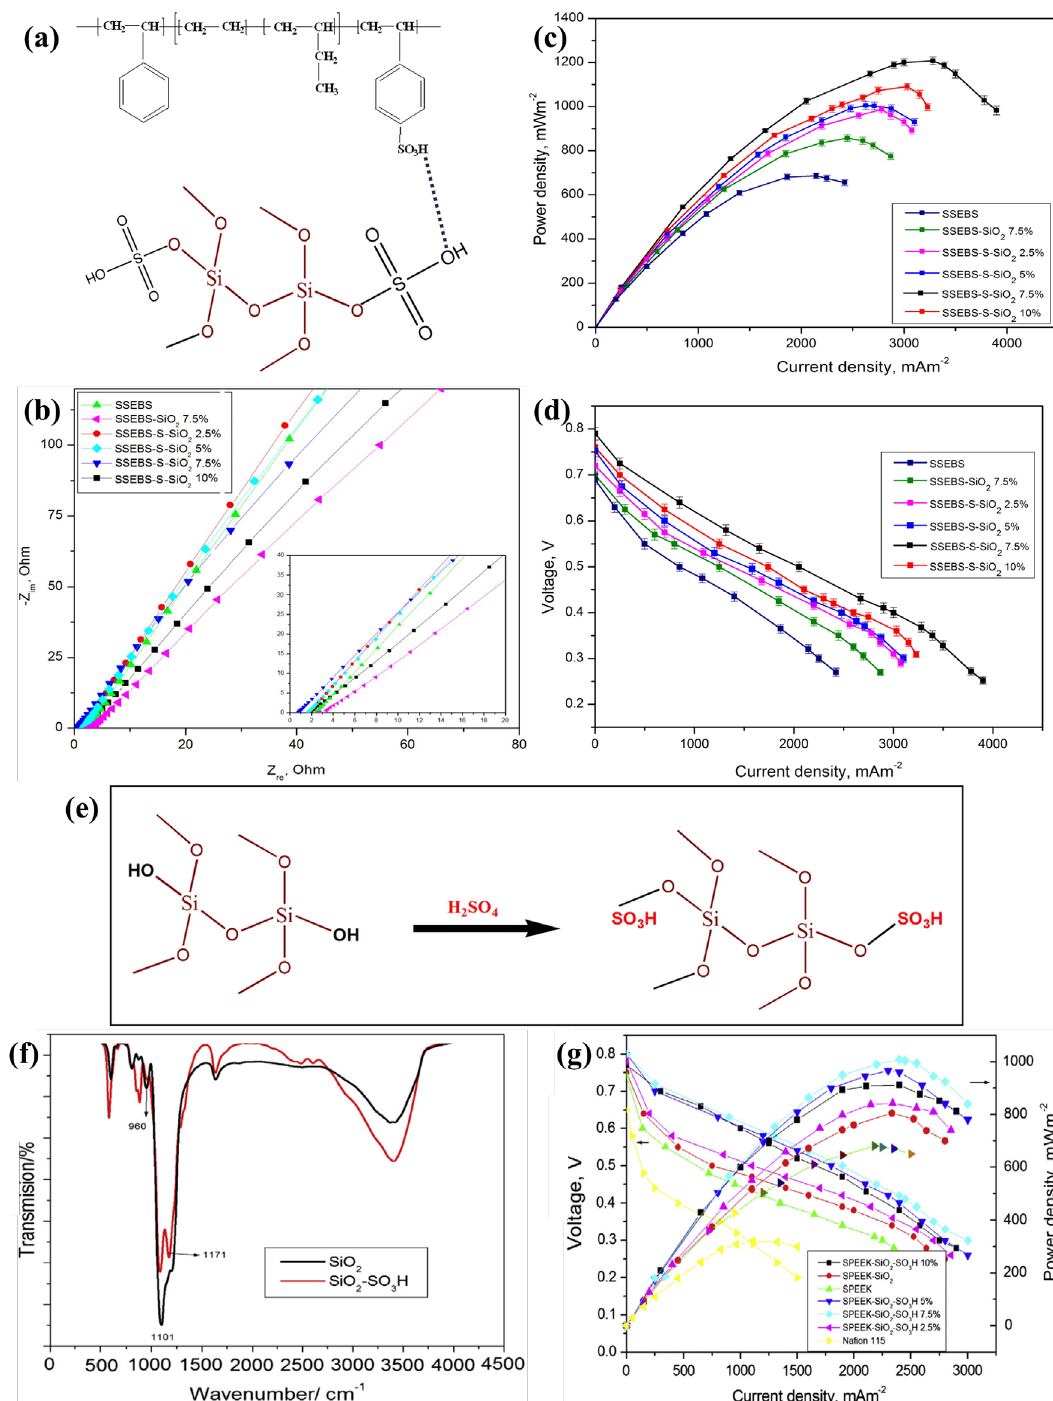
Figure 2. ( a ) A graphical representation of SSEBS polymer and sSiO 2 inorganic filler interaction. ( b ) Nyquist plots, ( c ) power density, and ( d ) polarization curves of SSEBS, SSEBS/SiO 2 (7.5%), and SSEBS/sSiO 2 (2.5, 5, 7.5, and 10%) membranes. Reproduced from [104], with permission from Elsevier, 2016. ( e ) Preparation of sSiO 2 , ( f ) FT-IR of SiO 2 and sSiO 2 , and ( g ) polarization curve and power density of Nafion 115, SPEEK, SPEEK-SiO 2 , and SPEEK-sSiO 2 membranes. Reproduced from [105], with permission from Elsevier, 2015.